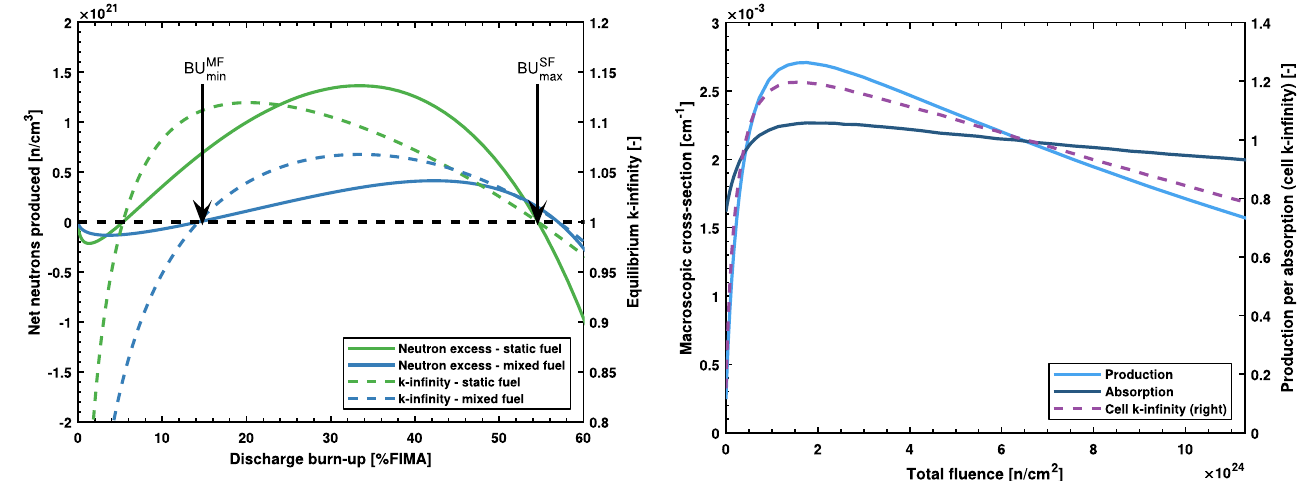
Fig. 2. Comparison of the neutron excess and equilibrium k ∞ using static-fuel and mixed-fuel distributions.